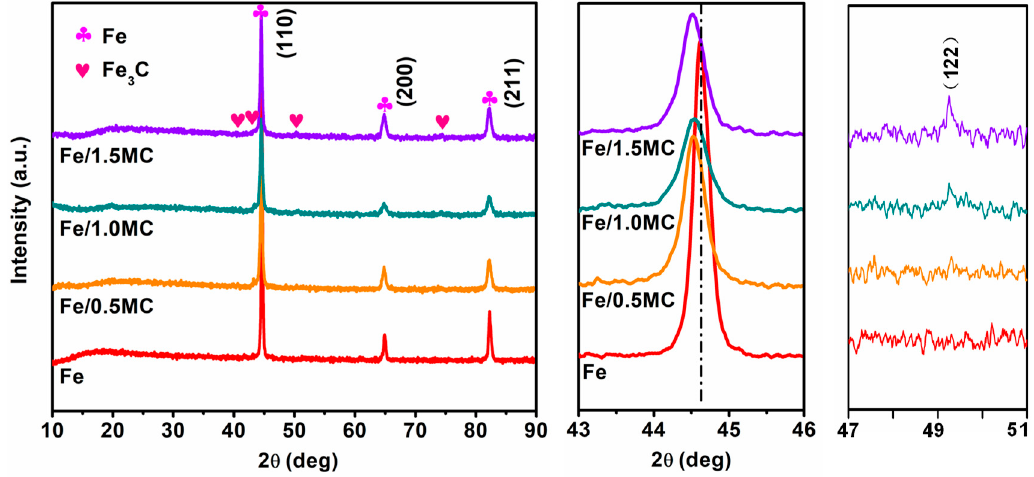
Figure 3. The XRD spectrum of Fe and Fe / MC